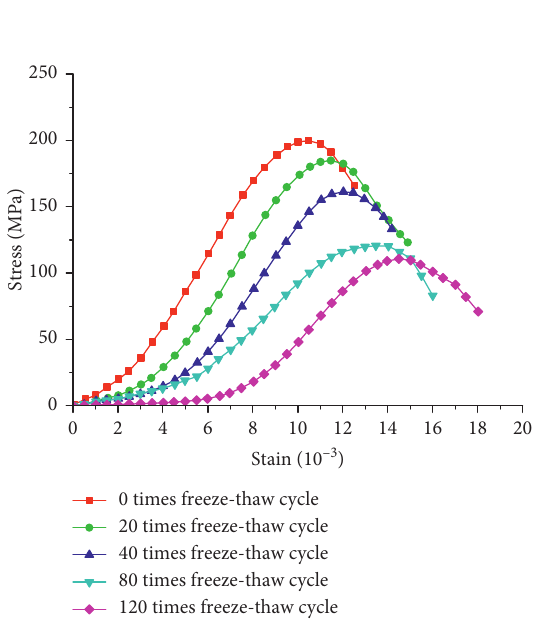
Figure 6: Stress-strain curve of sandstone with different freeze- thaw cycles under the impact pressure of